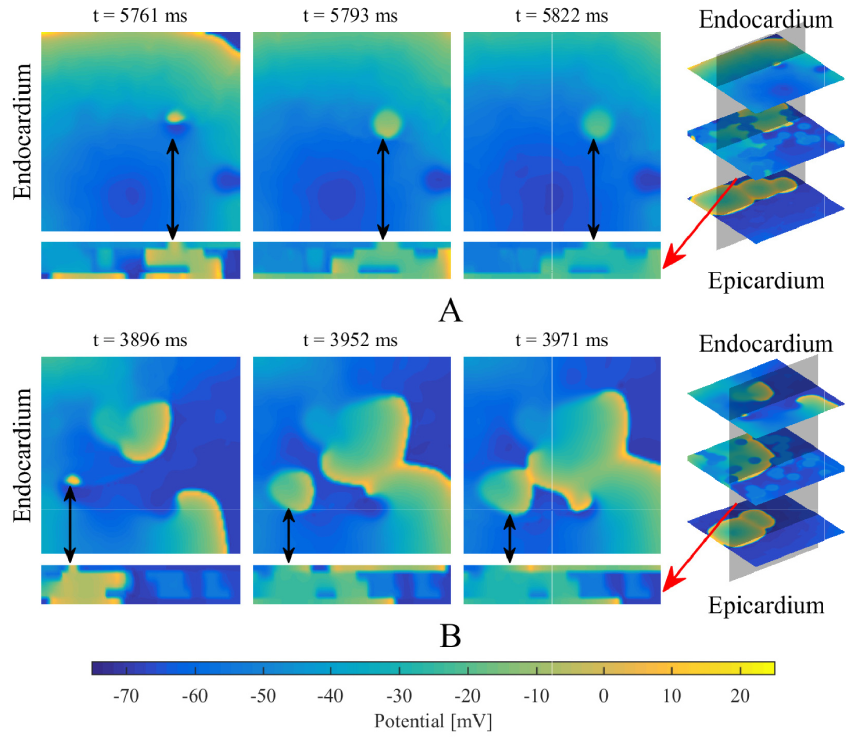
Fig 4. The definition of a breakthrough. (A) A wave (marked with black arrows) is annihilating in a very short time. (B) A breakthrough (marked with black arrows) produces a long enough propagation to affect other waves in the same layer. Red arrows denote the longitudinal section of the multi-layer